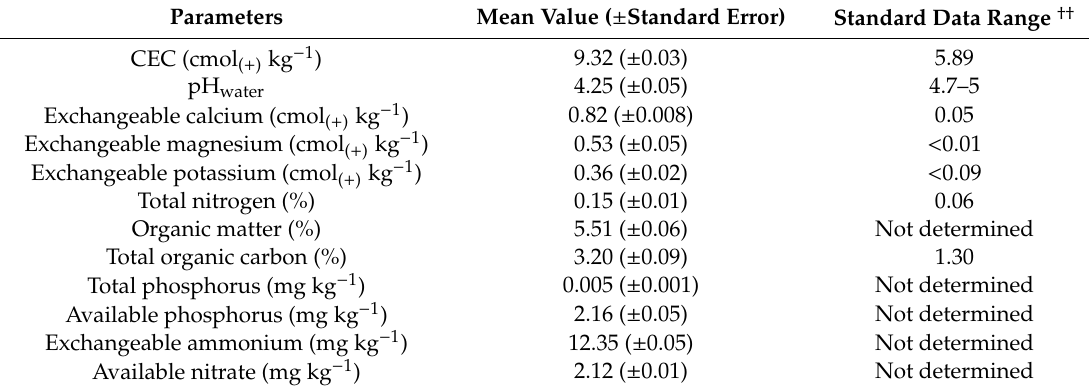
Table 3. Some chemical characteristics of the soil used in this